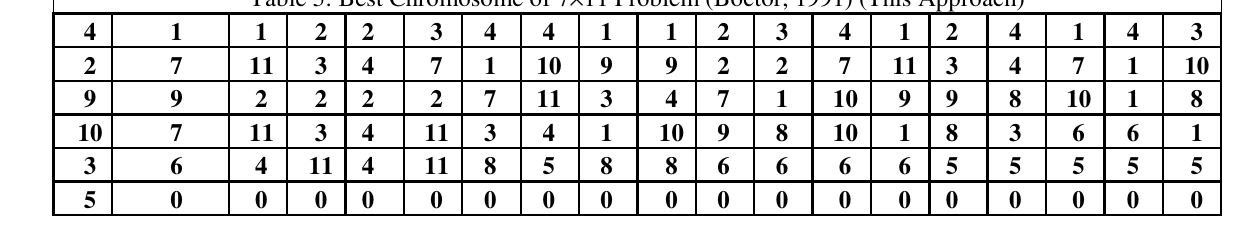
Table 7: Integrated Approach